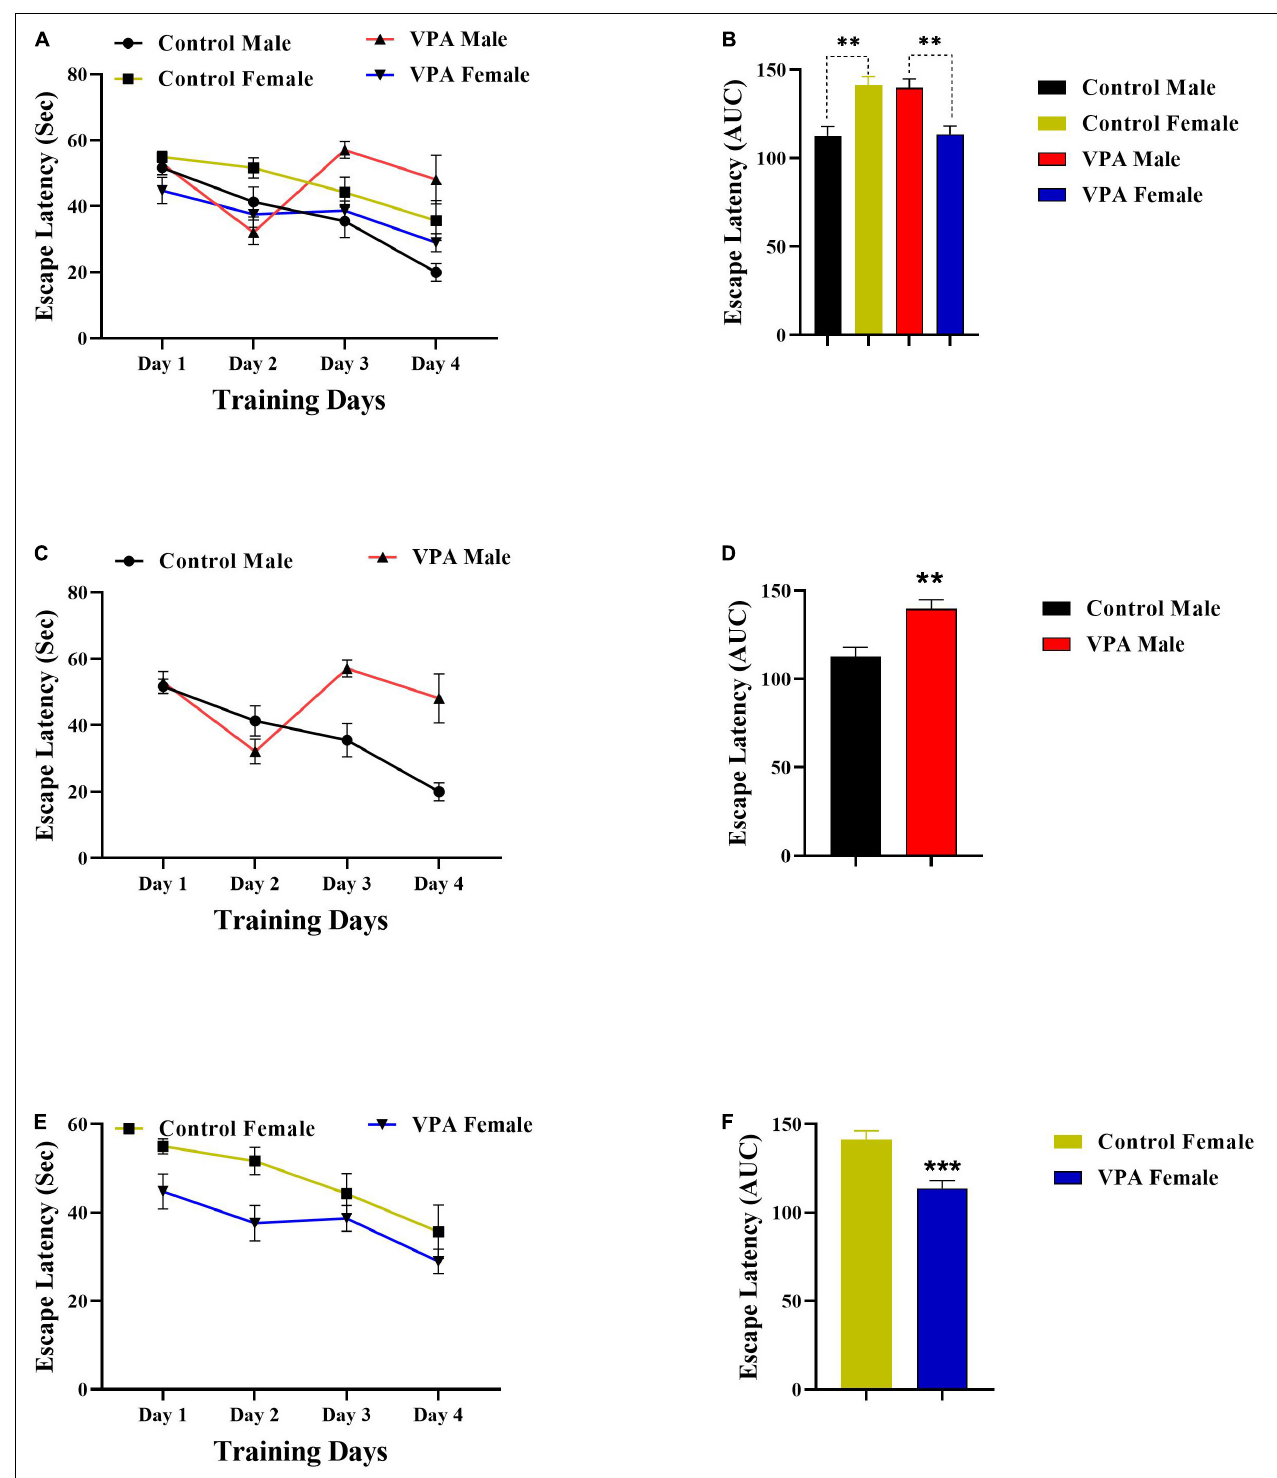
FIGURE 2 | Latency to find a hidden platform during training days. (A) Significant sex differences in the escape latency in control and VPA-exposed male and female offspring. (B) Area under the curve (AUC) for escape latency. (C) Significant differences in the escape latency in control and VPA-exposed male offspring. (D) AUC for escape latency in male offsprings. (E,F) Same analysis as (C,D) , respectively, but for female offsprings. Data are presented as mean ± SEM. ** p < 0.01, *** p < 0.001.